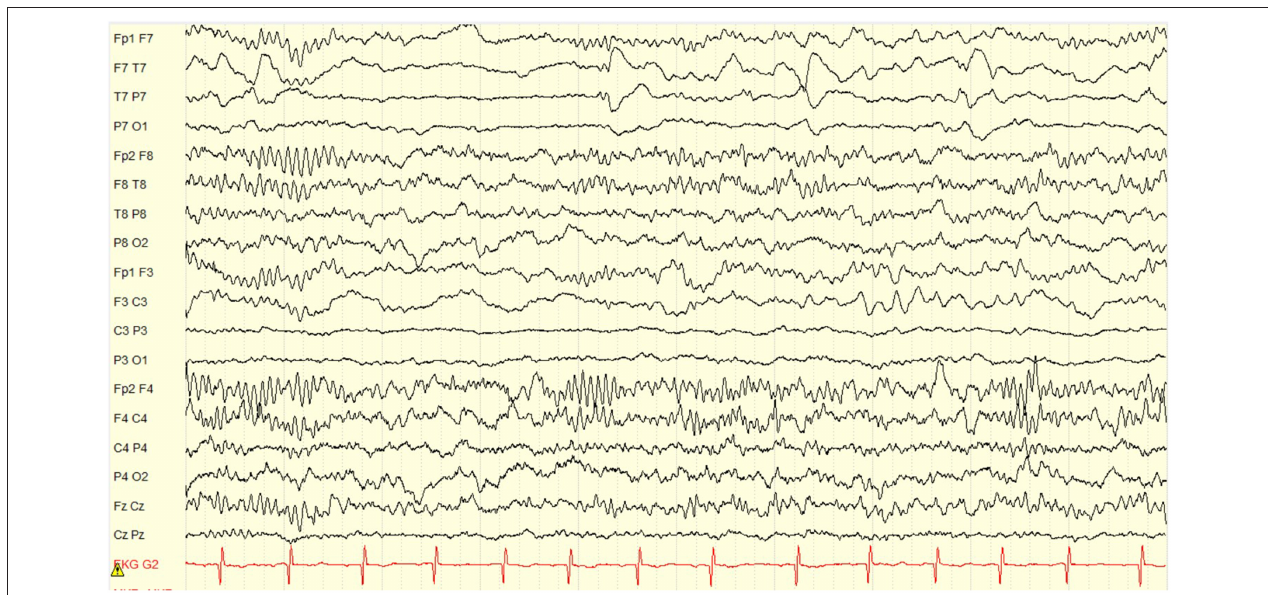
FIGURE 3 | Post-operative EEG obtained 14 months after left hemispherotomy. There is complete resolution of ESES with no interictal discharges. Only expected non-epileptiform changes of continuous slow and asymmetry of sleep structures in the left hemisphere are seen. Display setup: bipolar double banana montage,